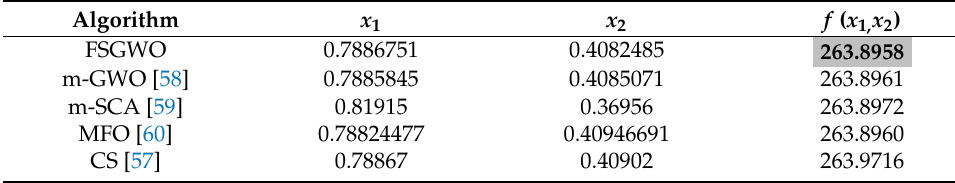
Table 14. Results of related algorithms for the three-bar truss design problem.